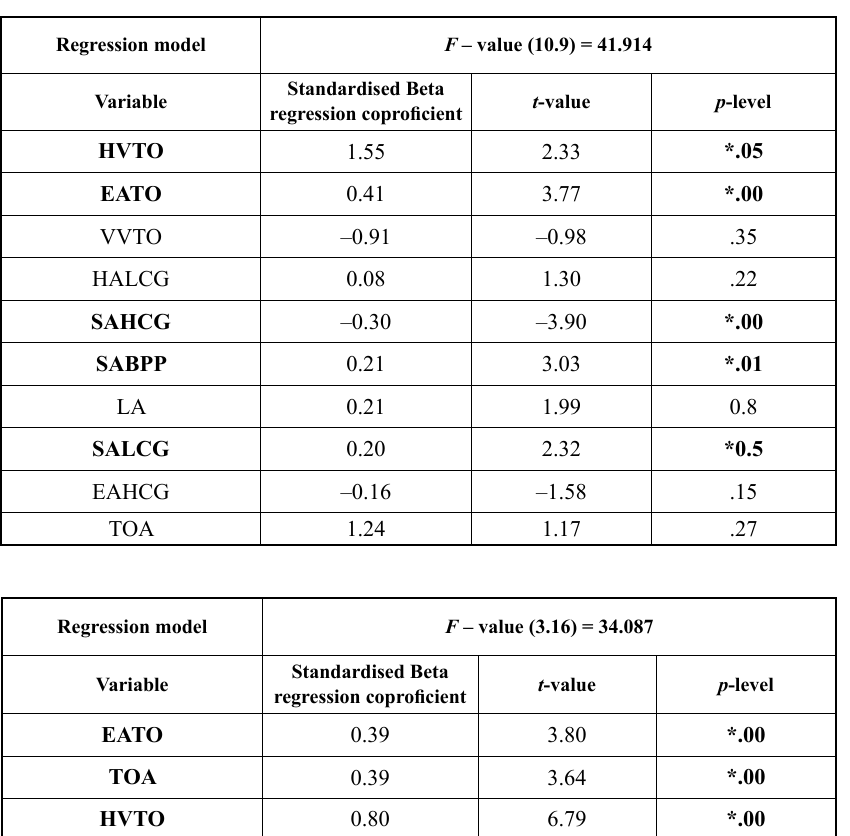
Table 5. Forward Stepwise Multiple